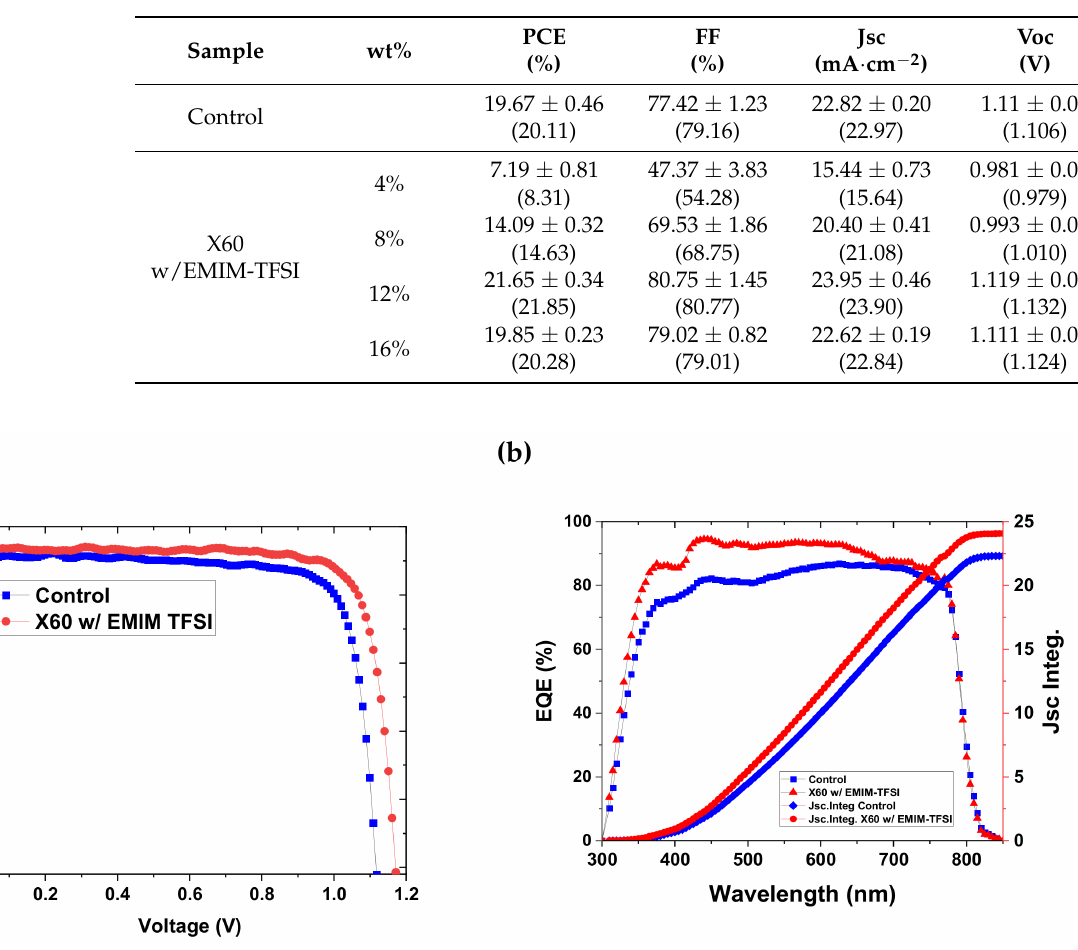
Table 1. The average photovoltaic parameters obtained from the J–V curves of the devices incorporat- ing varying EMIM-TFSI weight ratios. The photovoltaic parameters of the best performing devices are placed in brackets. The errors were calculated by device statistics.